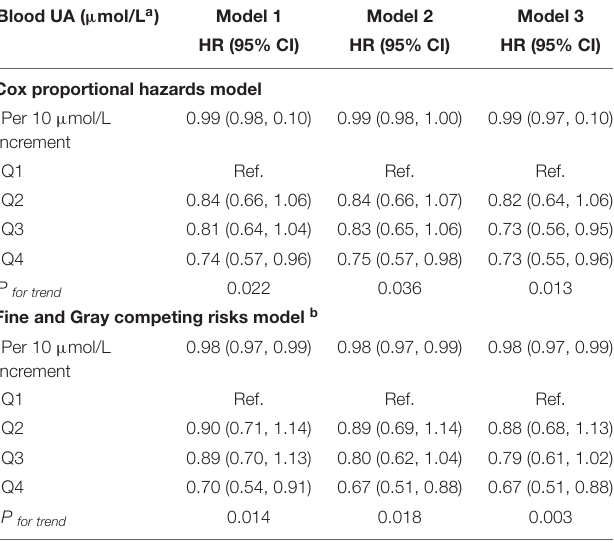
TABLE 3 | Longitudinal associations of blood UA levels with the risk of MCI.